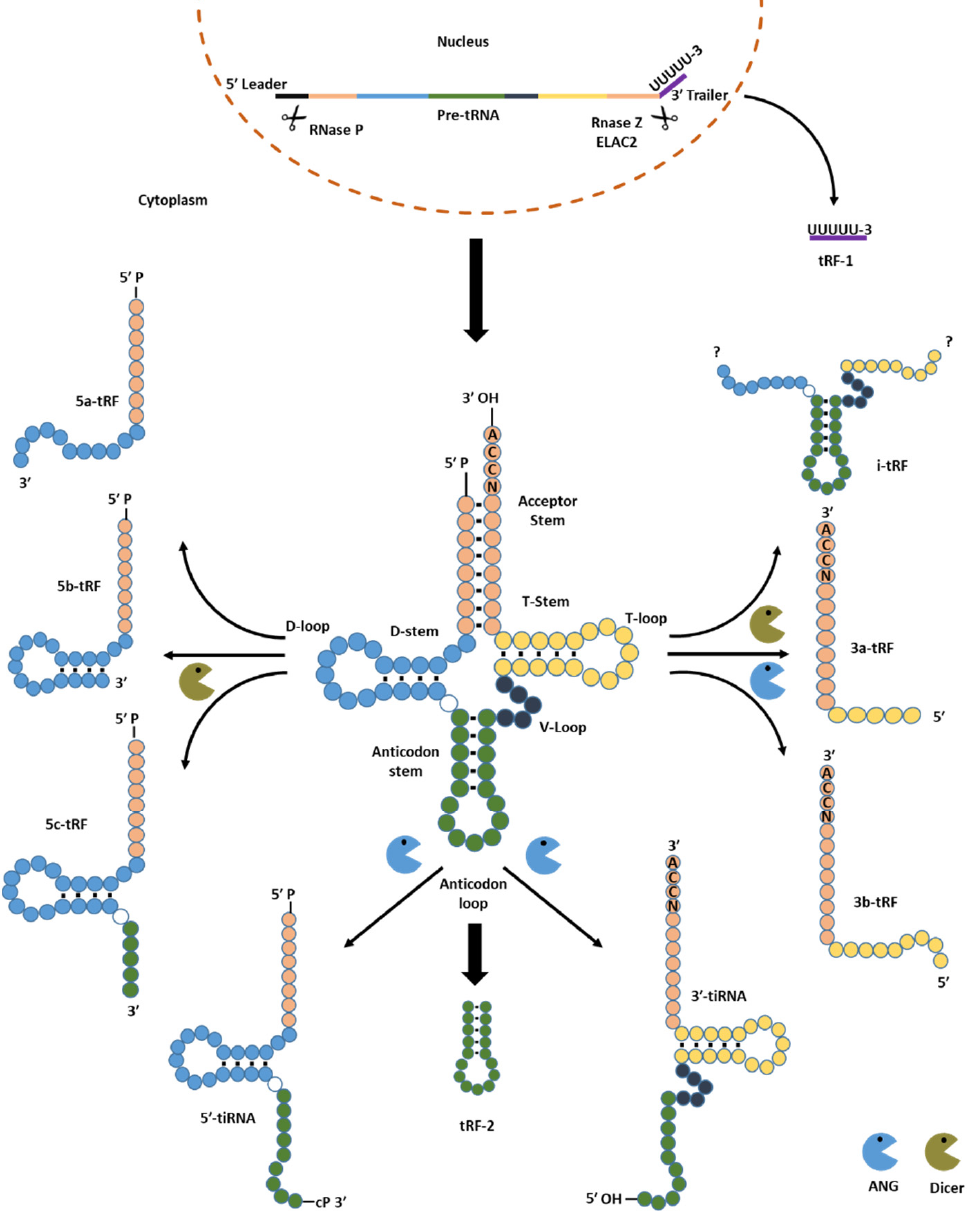
Figure 1. Classification of tRNA-derived fragments (tsRNAs) into tRF and tiRNA (tRNA halves). Graphical representation describing the exonuclease activity of angiogenin and Dicer to digest mature tRNAs .